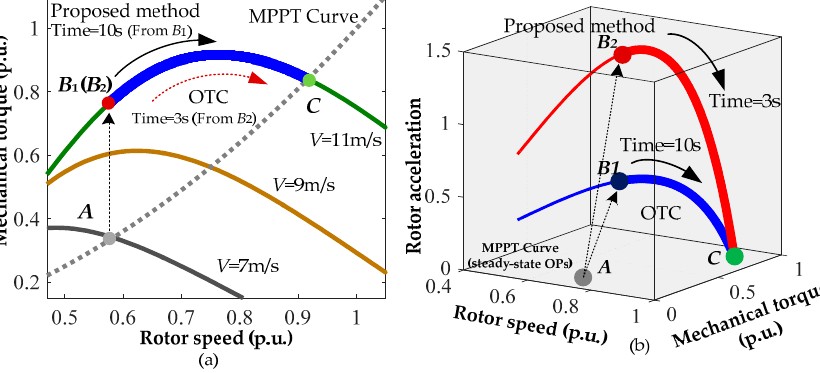
Figure 6. Moving locus of operation points, ( a ) 2D view; ( b ) 3D view with rotor acceleration included.